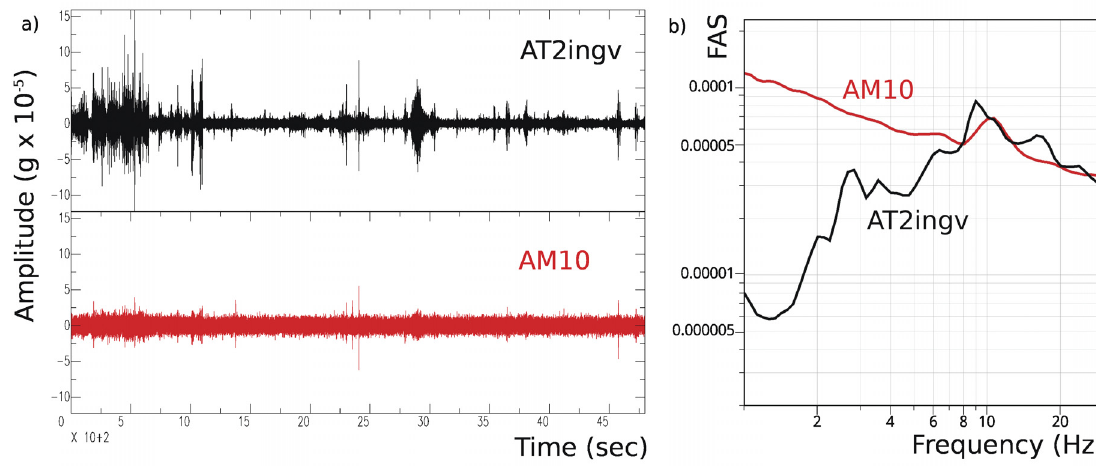
, black curves) ingv and AM10 is 1.5 m (along the vertical direc- ingv